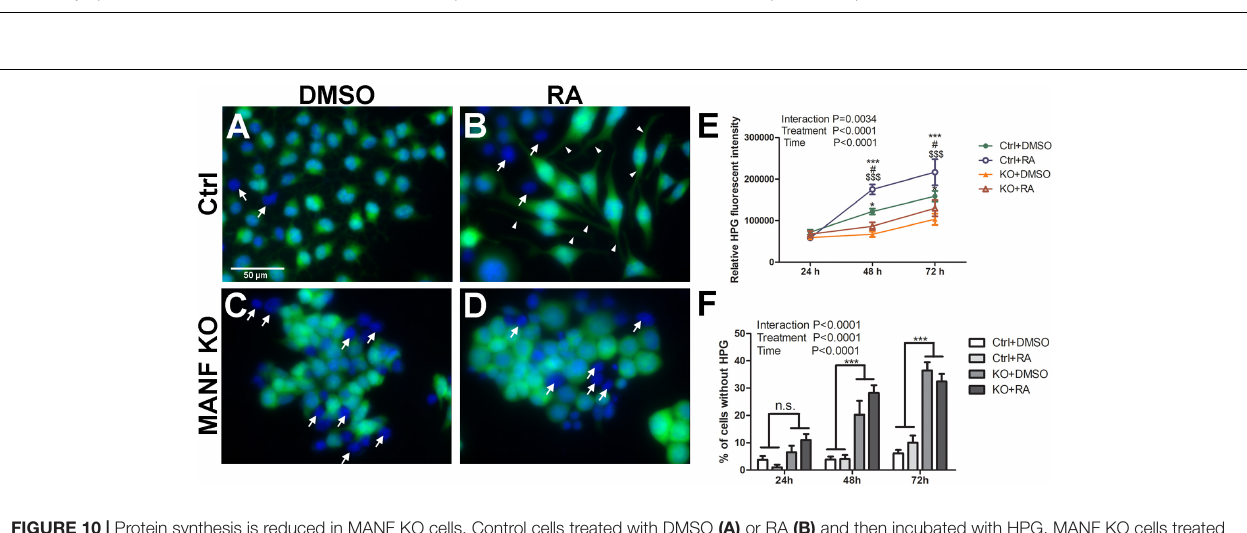
FIGURE 10 | Protein synthesis is reduced in MANF KO cells. Control cells treated with DMSO (A) or RA (B) and then incubated with HPG. MANF KO cells treated with DMSO (C) or RA (D) and then incubated with HPG. White arrows indicate cells without HPG signal (cells lacking nascent protein synthesis); white arrow heads indicate neurites with HPG signal. (E) HPG fluorescence intensities in control and MANF KO cells were quantified and analyzed by Two-way ANOVA followed with the Bonferroni’s post hoc test. # P < 0.05 compared to Ctrl DMSO; * P < 0.05, *** P < 0.001 compared to KO DMSO; $$$ P < 0.001 compared to KO RA. The data were expressed as the mean ± SEM of three independent experiments. (F) Percentage of cells without HPG signal was quantified, and analyzed by Two-way ANOVA followed with the Bonferroni’s post hoc test, *** P < 0.0001, n.s. not statistically significant. The data were expressed as the mean ± SEM of three independent